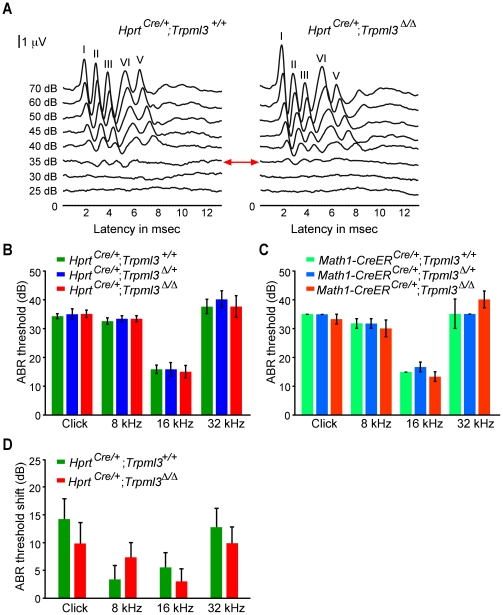
ABR measurements.A, Graph shows representative ABR waveforms of 3-week-old HprtCre/+; Trpml3+/+ and HprtCre/+; Trpml3 Δ/Δ mice in response to a click stimulus. ABRs were recorded at sound stimulation intensities of 25–70 dB. ABR waves I–V are indicated above the peaks. Red arrow highlights the hearing threshold, which is at 35 dB in this representative example pair. B, Shown are ABR thresholds (mean values ± SEM) to click, 8-, 16-, and 32 kHz stimuli of HprtCre/+;Trpml3+/+ (n = 6), HprtCre/+;Trpml3Δ/+ (n = 6), and HprtCre/+;Trpml3 Δ/Δ (n = 6) and C, of Math1-CreERCre/+;Trpml3+/+ (n = 3), Math1-CreERCre/+;Trpml3Δ/+ (n = 3), and Math1-CreERCre/+;Trpml3 Δ/Δ (n = 3), respectively. Statistical comparisons of means of different genotypes were made using one-way ANOVA followed by Tukey's post test; p>0.05. D, ABR threshold shifts of 3-month-old HprtCre/+;Trpml3+/+ (n = 7) and HprtCre/+;Trpml3 Δ/Δ (n = 7) 1 week after the acoustic overexposure of 125 dB SPL at 4 kHz for 4 hr. Shown are mean values ± SEM. No significant differences were observed between genotypes (p>0.05, one-way ANOVA, followed by Tukey's post test).